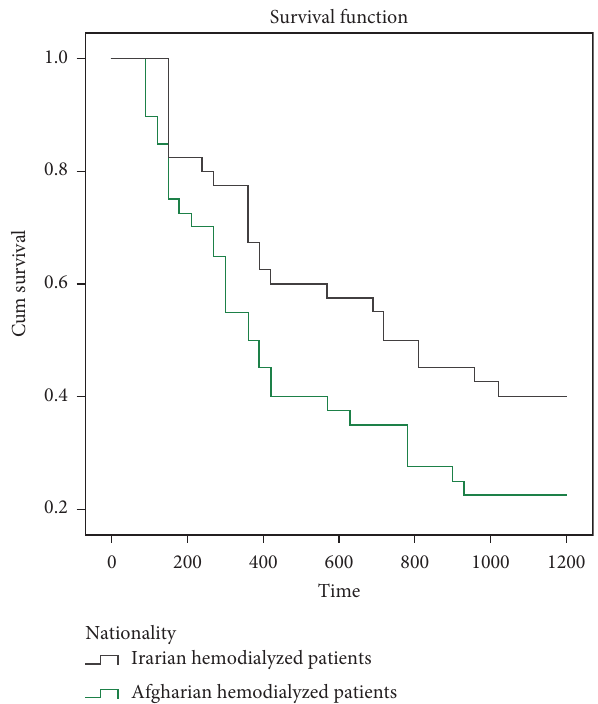
Figure 1: The Kaplan–Meier survival plot shows more longevity in chronically hemodialyzed Iranian patients compared with their less adequately hemodialyzed Afghan counterparts. Table 4: Some demographic, cultural, medical, social, and economic characteristics of two groups that were discerned during the study. Group